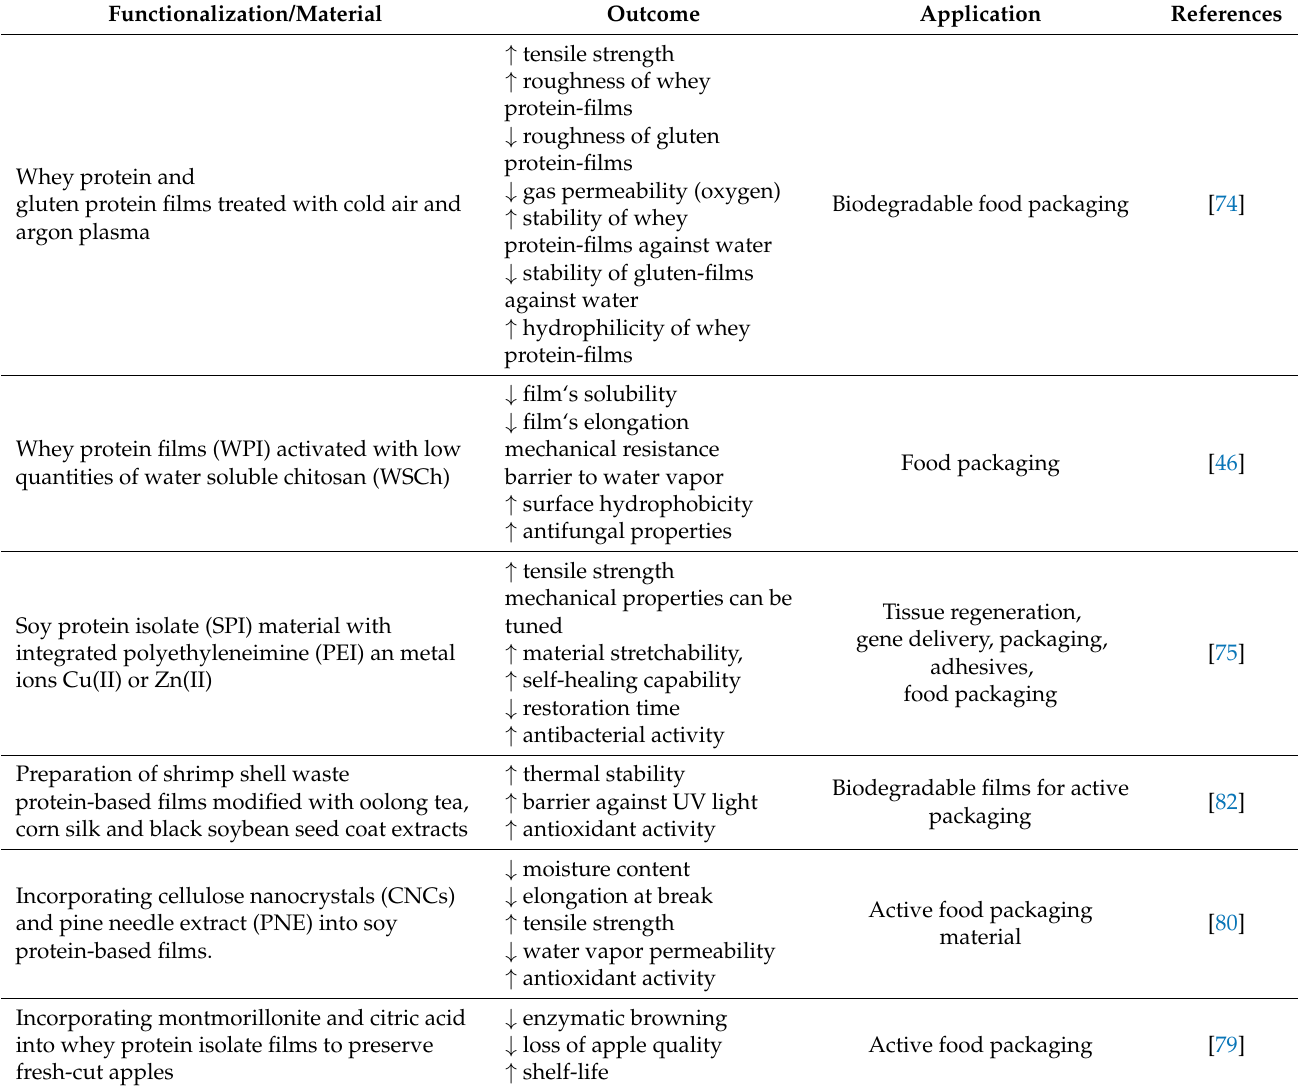
Table 2. Overview of the functionalization and proposed application of protein-based packages.